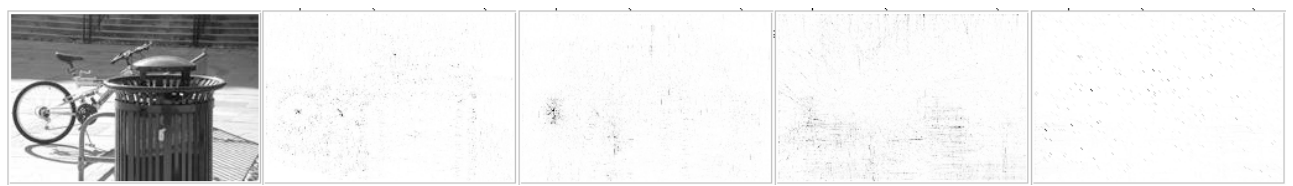
Figure 8b . Original images and the resulting fast radial symmetry transform maps of ranges